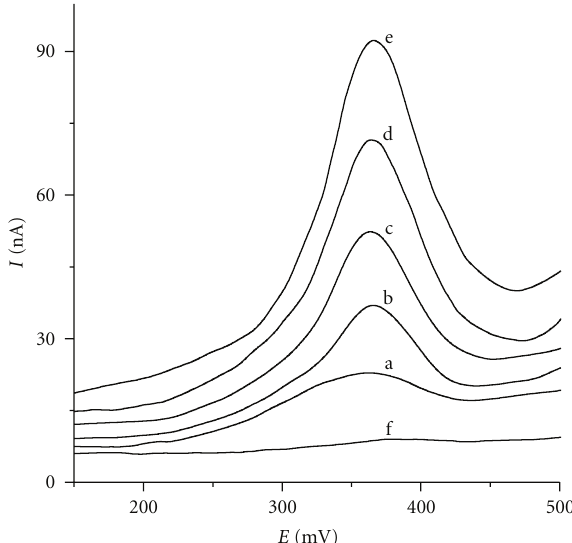
Figure 9: Di ff erential pulse voltammograms of tenfold diluted boiling water extract of buckwheat seeds (a) at IP/CPE and four standard additions of rutin: 20nmol (b), 40 nmol (c), 60 nmol (d), and 80nmol (e) in acetate bu ff er pH = 4 as supporting electrolyte